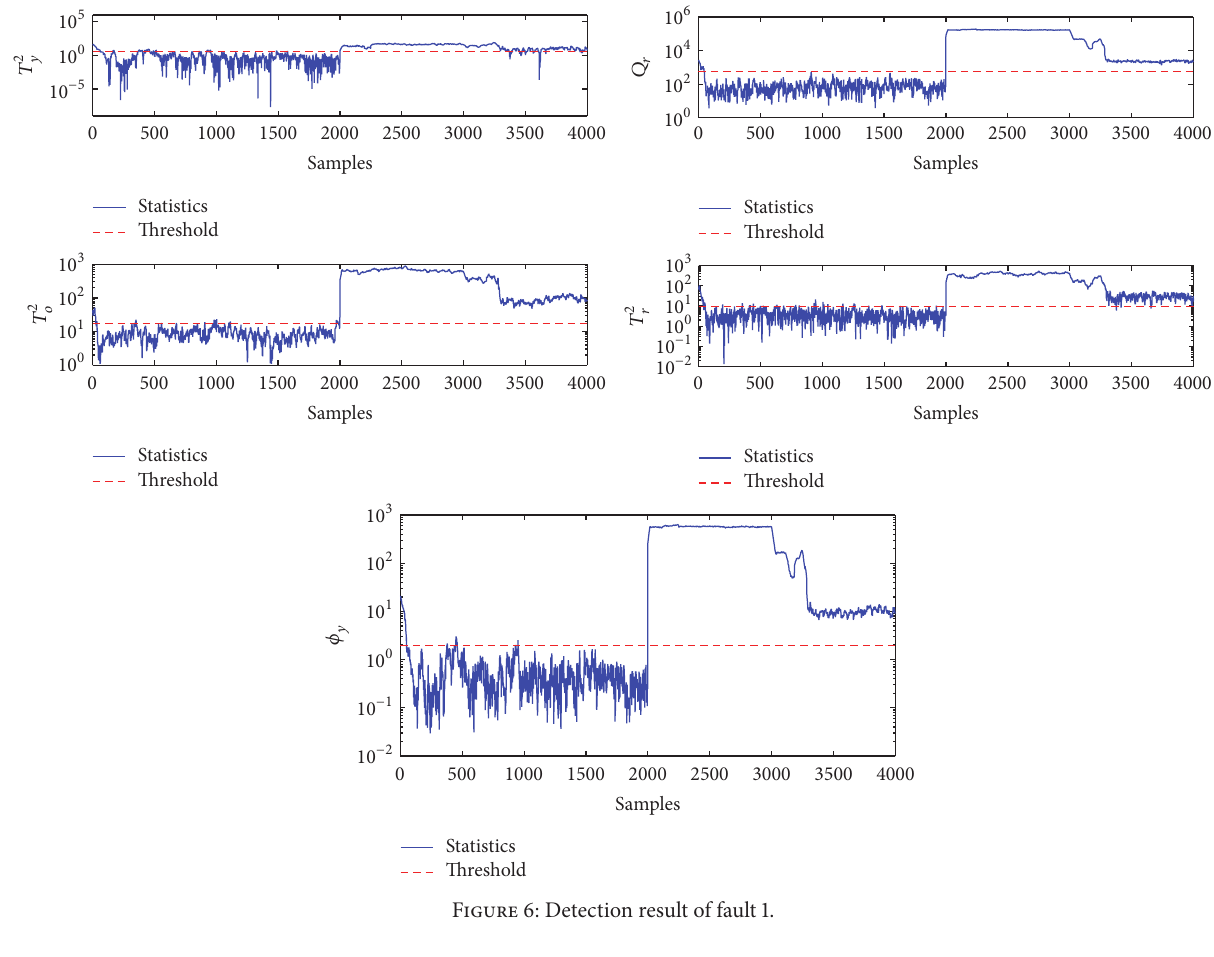
Figure 6: Detection result of fault 1.